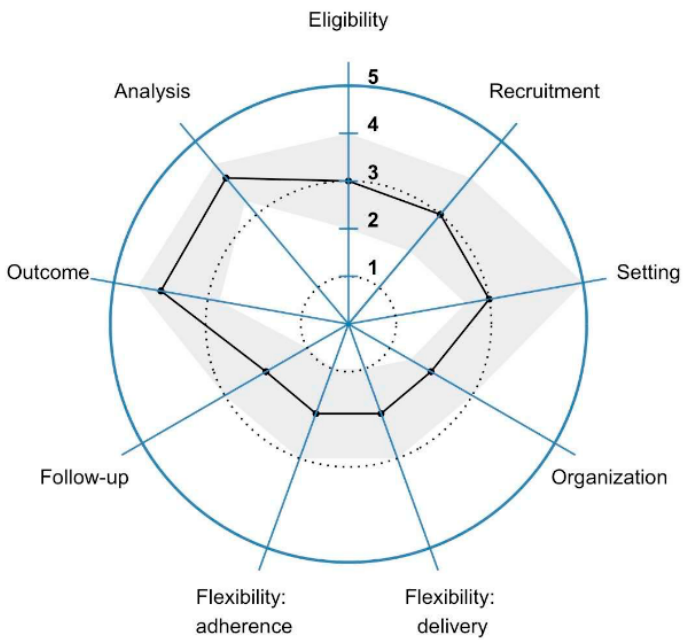
Figure 2. The Pragmatic Explanatory Continuum Indicator Summary 2 (PRECIS-2) wheel ranking the degree of pragmatism for the nine PRECIS-2 domains. In this figure, we report median (black line) and interquartile range (gray shaded area) ranks of the responses for of the 35 Household Air Pollution Intervention Network (HAPIN) investigators. It uses a five-point Likert rank scale from very explanatory (1) to very pragmatic (5) to rank each of these domains.